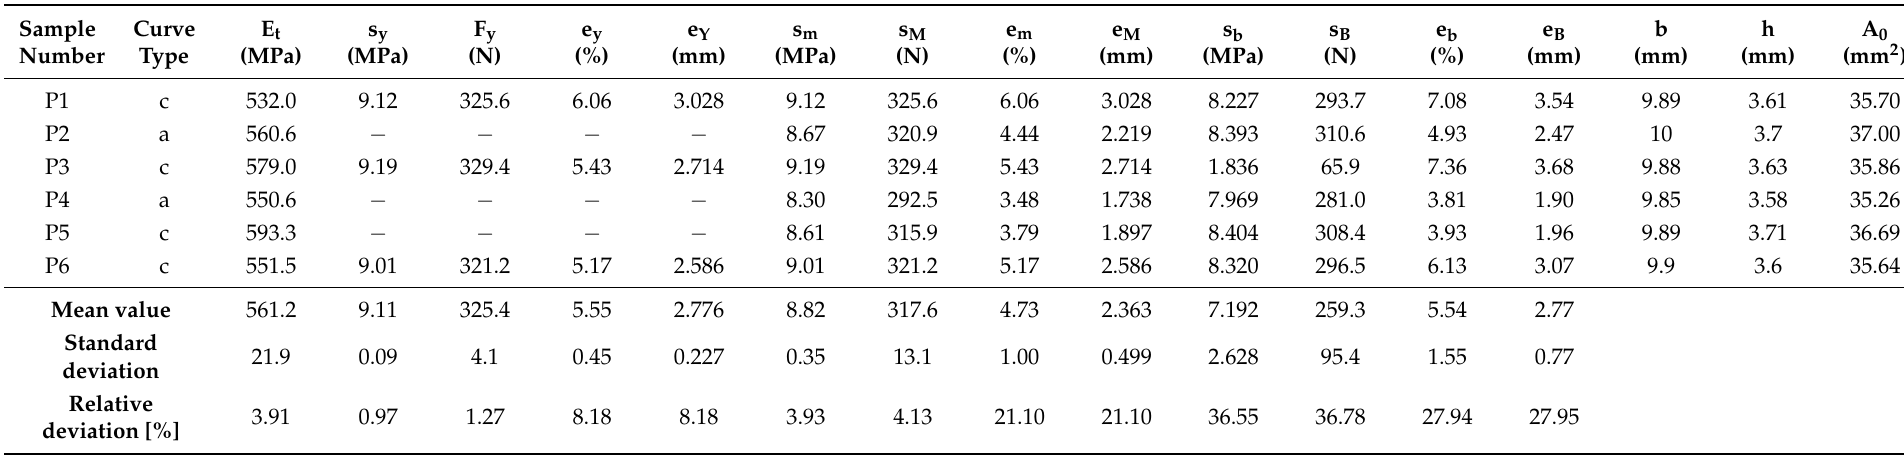
Table A26. Results of the tensile tests of P_PE.